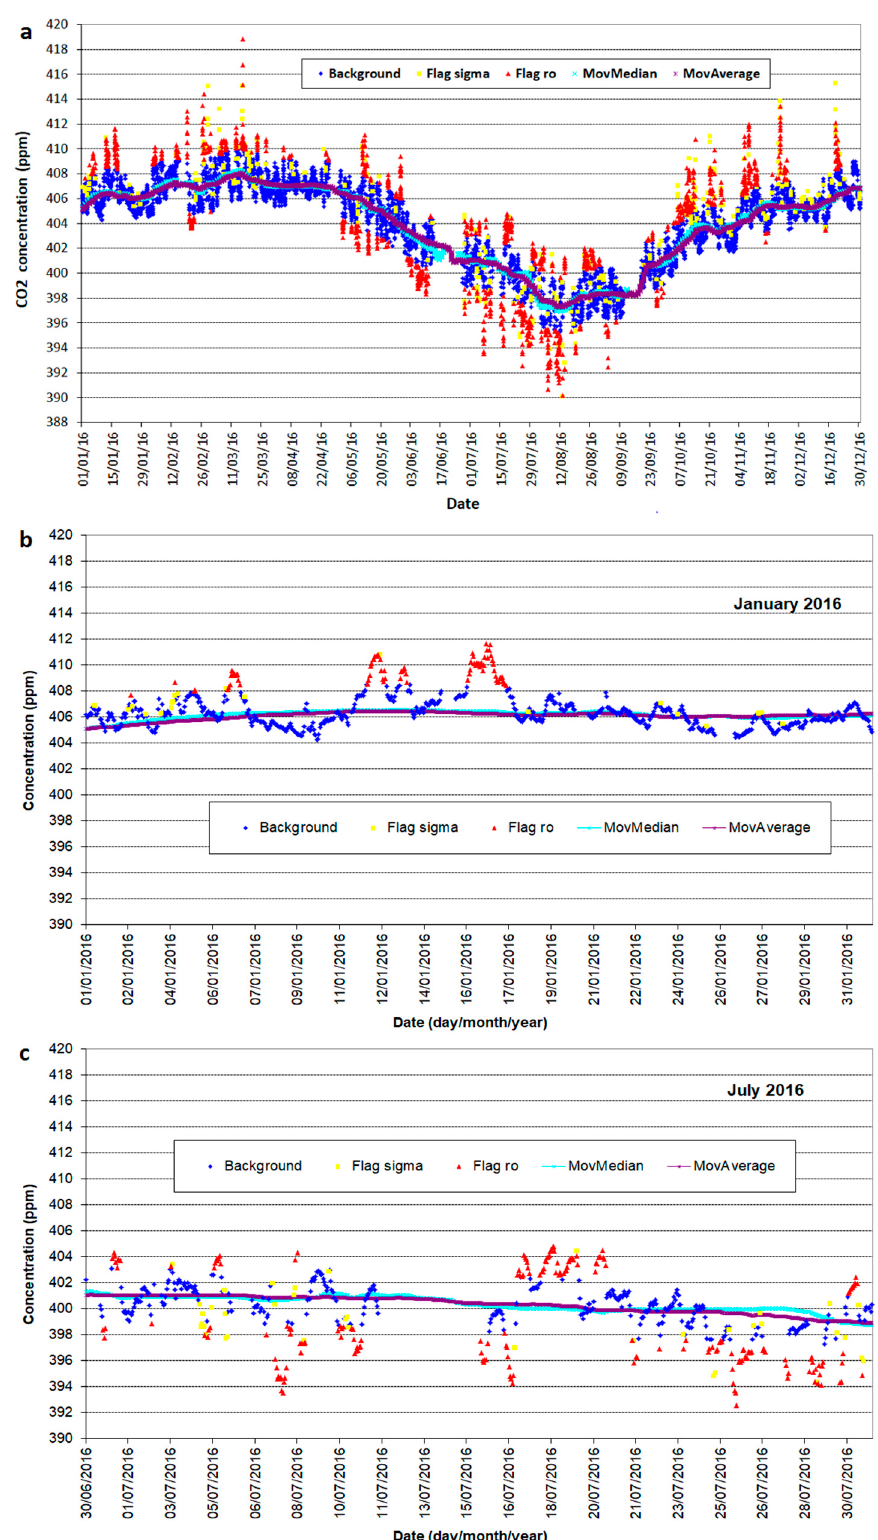
Figure 5. The triangles represent all the raw hourly data measured in 2016 at PRS. The yellow triangles refer to the data that did not pass step 1 and the red ones to those that did not pass step 4. The blue triangles refer to the data that were considered background data. The curves in cyan and brown represent the moving median and moving average computed for 21 days of measurements, respectively, year 2016 ( a ), in January 2016 ( b ) and in July 2016 ( c ).